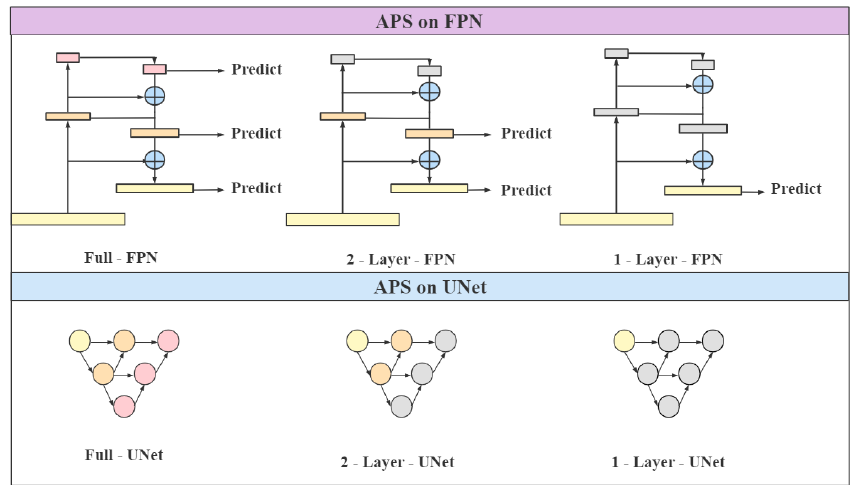
Figure 7. Illustration of pruning process of feature pyramid network and